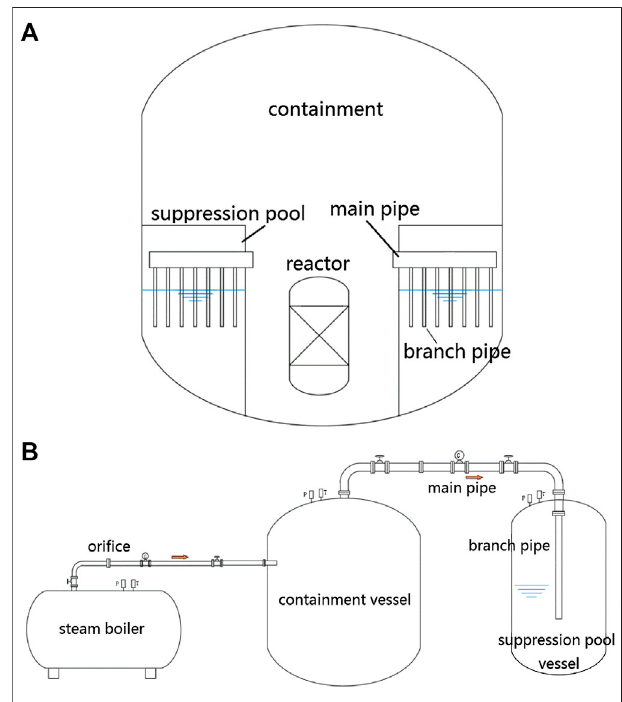
FIGURE 1 | Prototype and experimental facility. (A) Hypothetical small pressurized water reactor (PWR) containment and (B) schematic diagram of the scaling experimental